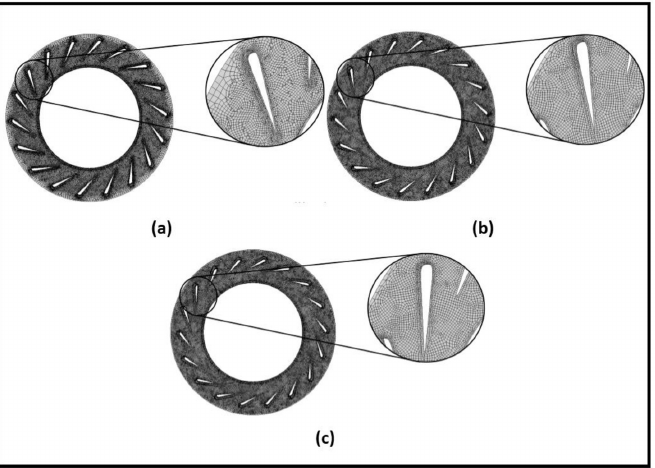
Figure 6. The hexahedral mesh of the VTG domain at: ( a ) 30 ◦ , ( b ) 20 ◦ , ( c ) 11 ◦ opening.